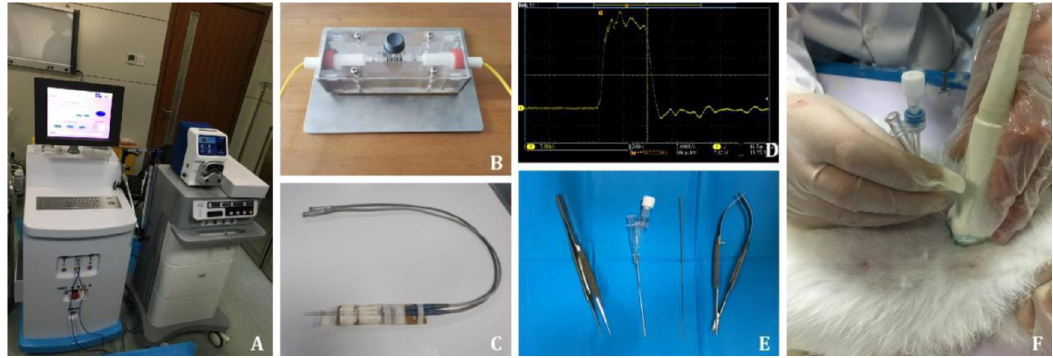
Fig 1. Ablation apparatus and the inoculation of rabbit VX2 liver tumors. A : The nsPEF ablation instrument is on the left, and the radiofrequency ablation instrument is on the right. B : Device for treating cells with nsPEFs. C : Ablation electrodes in animal experiments. D : The pulse waveform generated by nsPEFs. E : Preparation of the needles and tweezers. F : Percutaneous puncture under ultrasound guidance. nsPEFs: nanosecond pulsed electric fields.